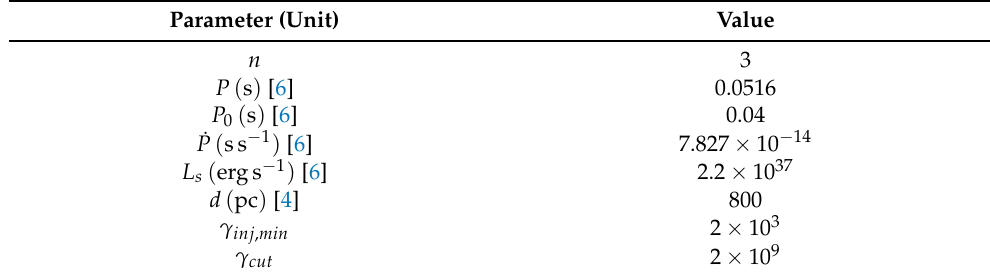
Table 2. Fixed parameters of the